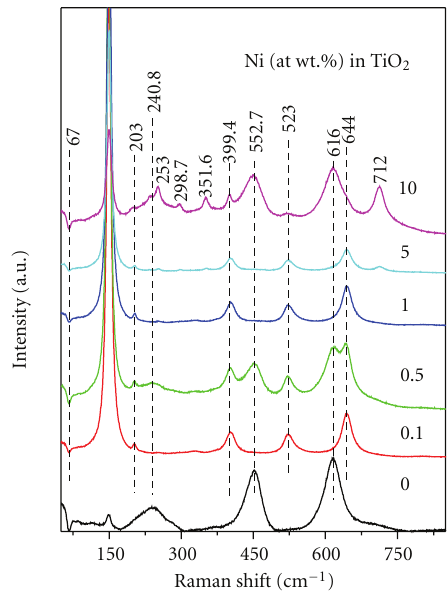
Figure 6: FT-Raman spectra of Ni-doped TiO 2 (Ni = 0, 0.1, 0.5, 1, 5, and 10 at. wt.%) powders formed at 550 ◦ C for